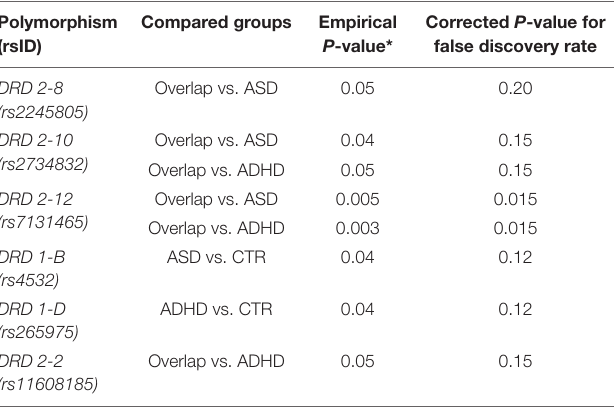
TABLE 4 | Results of the comparative analysis of genotype distribution of the SNPs among the study groups. Polymorphism